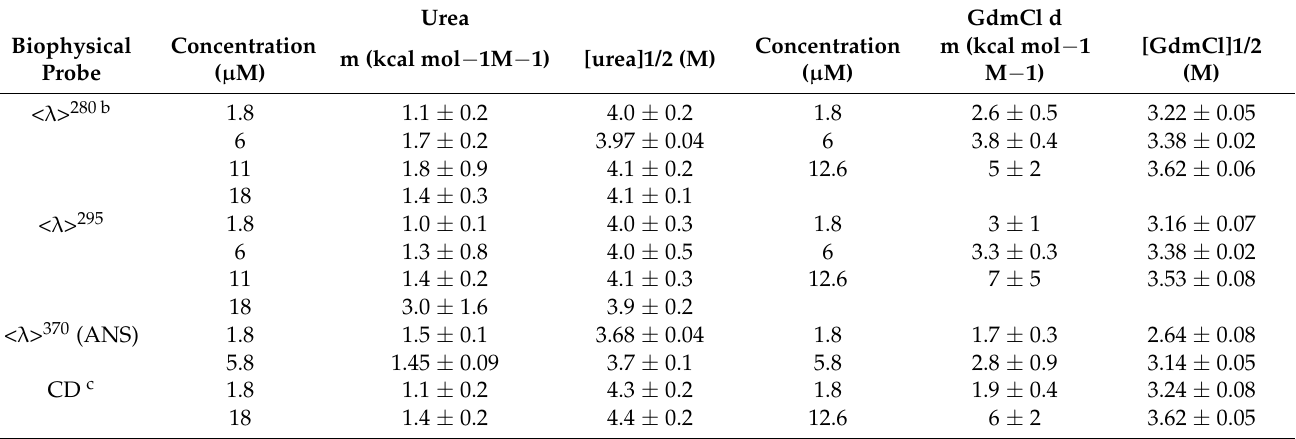
Table 2. Chemical denaturations of bsHPrK/P a